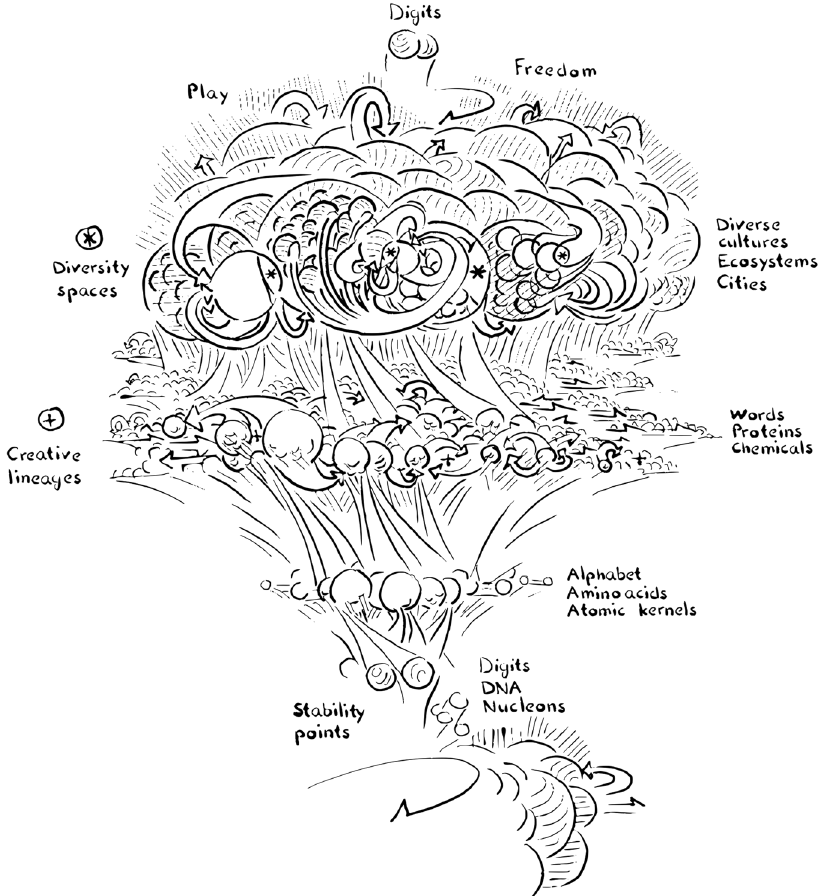
Fig. 7 From digits to diversity. Life repeatedly goes from basic building blocks to diversity. This progression can be traced over distinct levels of creativity and diversi fi cation. Source: Dan C. Baciu. License: